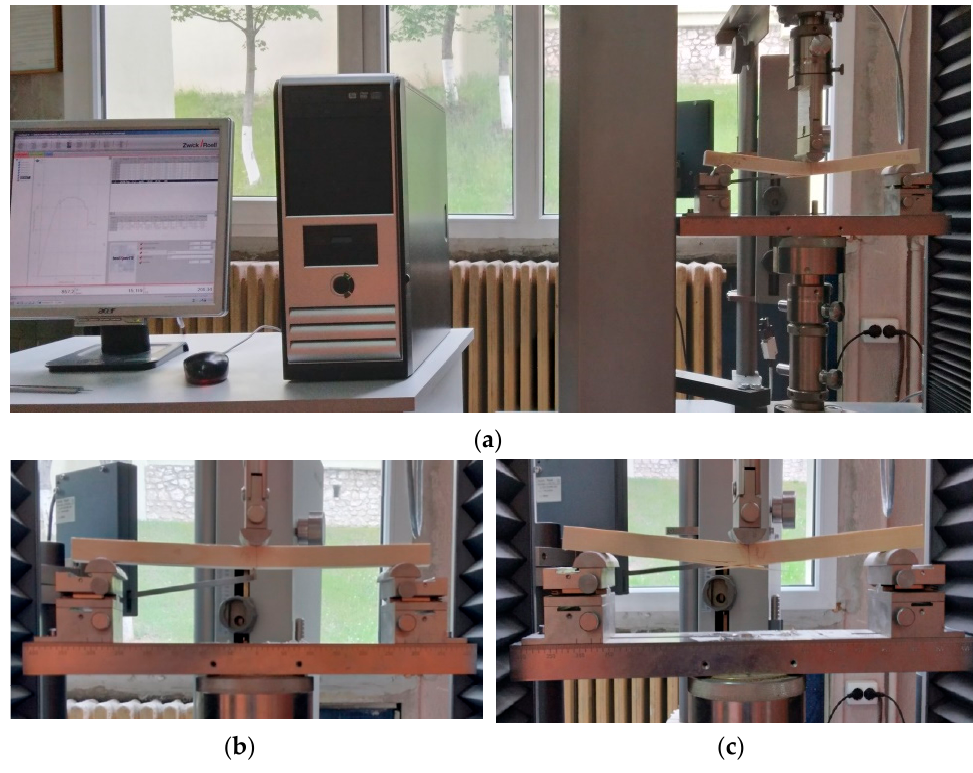
Figure 5. ZWICK/ROELL equipment type BT1FB050TN.D30/2007 ( a ) used for the determination of MOE ( b ) and MOR ( c ).